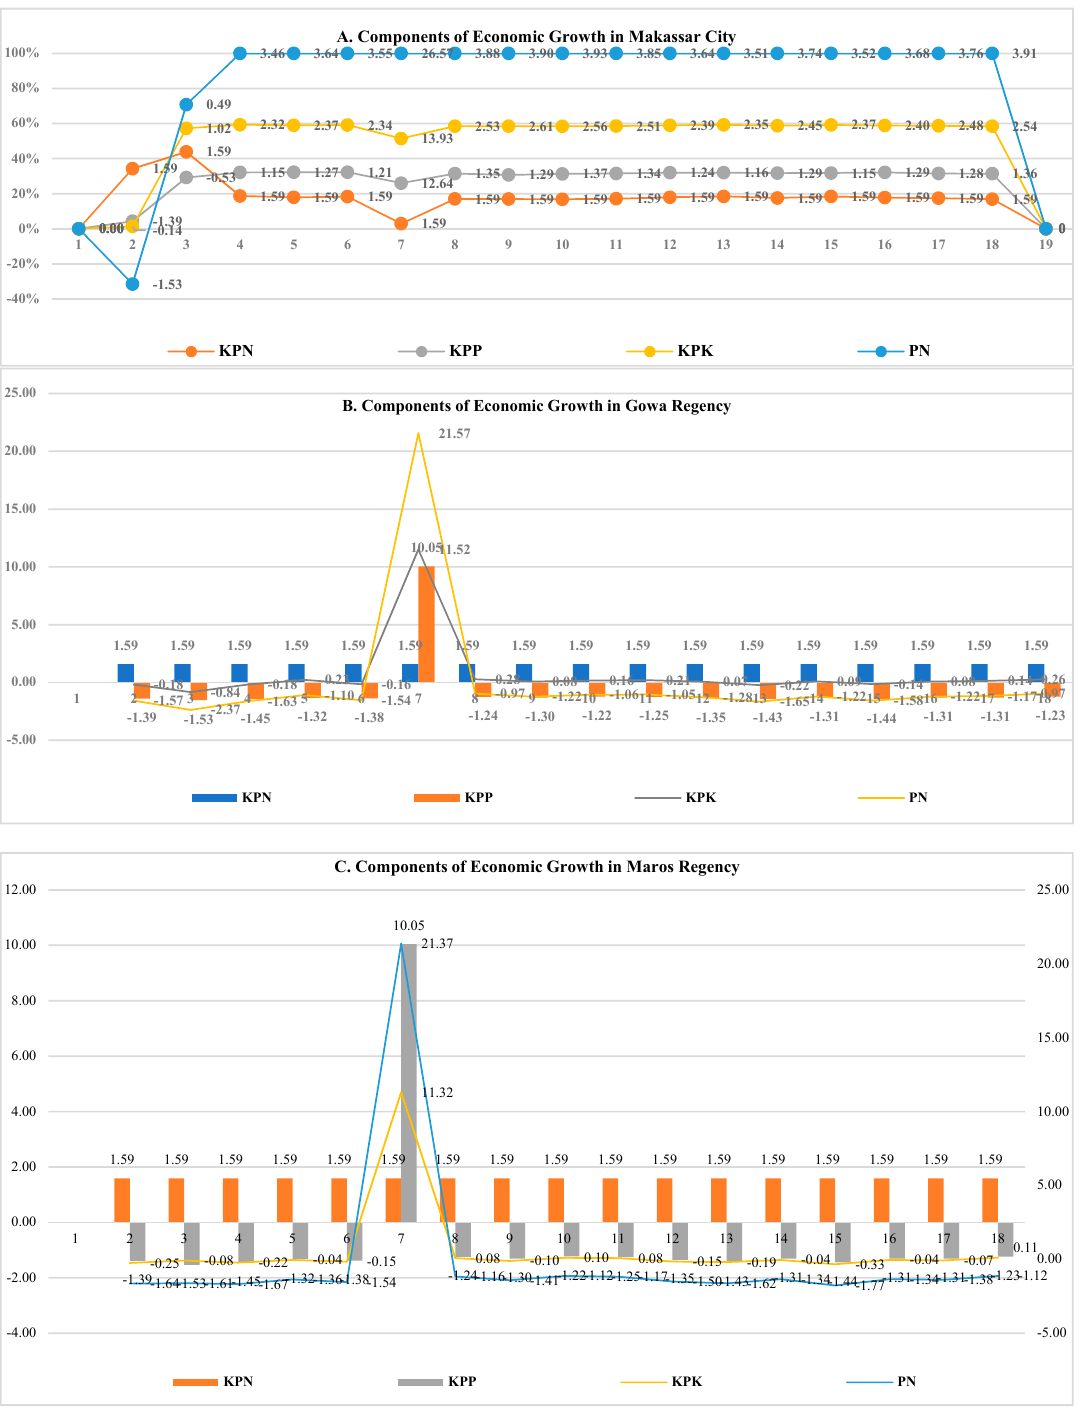
Figure 11. A, B, and C, Components of Economic Growth in the Mamminasata Metropolitan Urban Figure 11. ( A – C ), Components of Economic Growth in the Mamminasata Metropolitan Urban Area. Area. Source: author elaboration, infut: reference [90]. Source: author elaboration, infut: reference